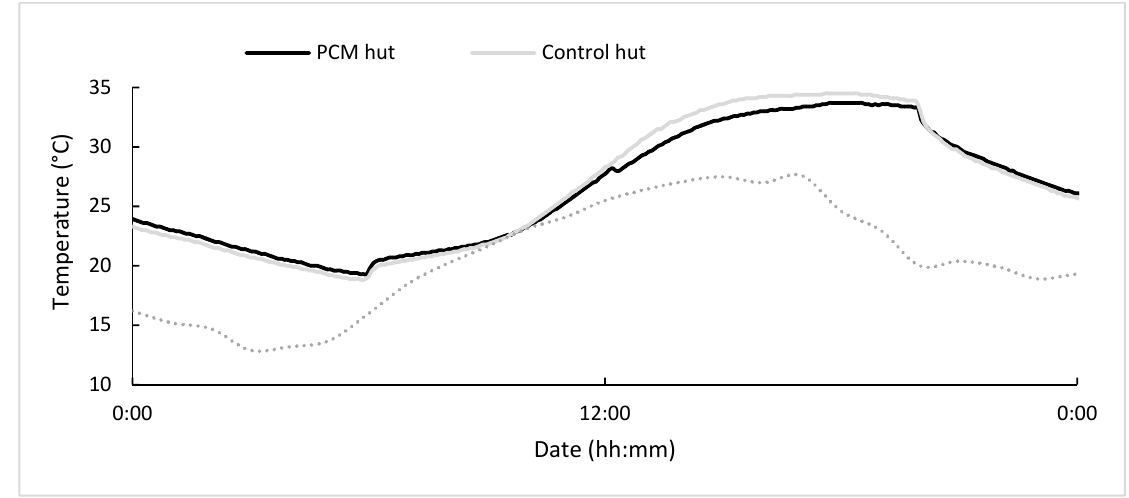
Figure 8. Temperature of the huts for a summer day with a cold night (13/07/2018). Table 5. Maximum temperature of the huts for summer days with cold nights.